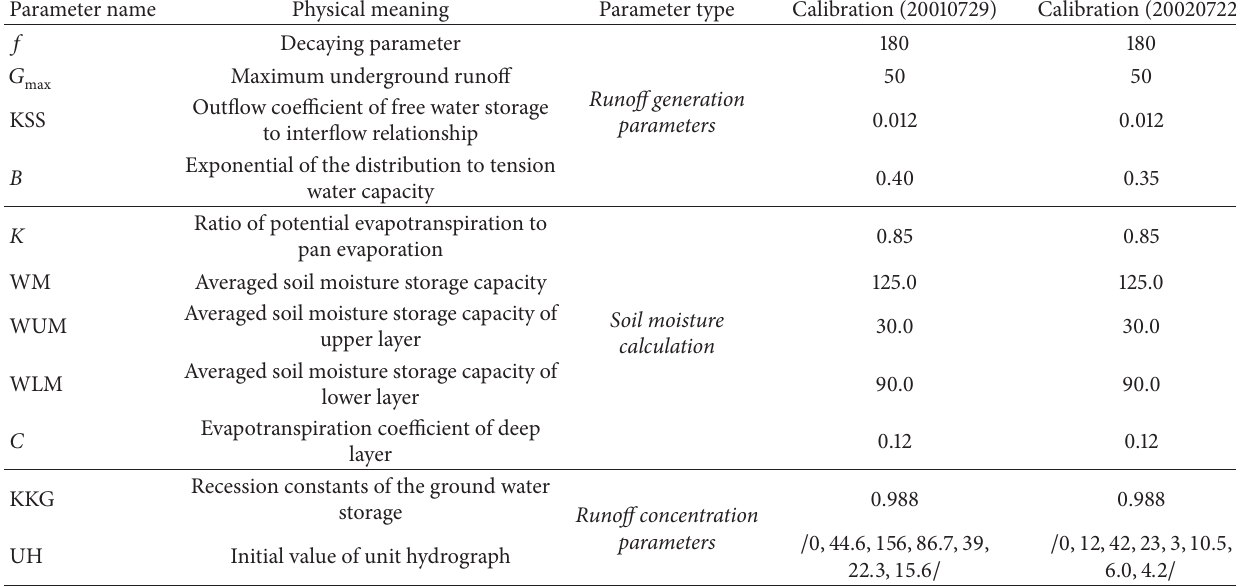
Table 1: Some major parameters in TOPX model with calibration